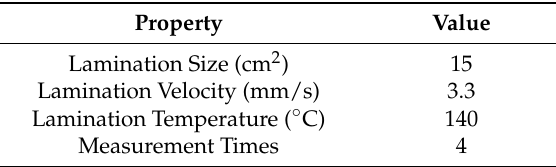
Table 2. Experimental conditions to produce PAN nanofiber air filter by the heat roller of SKY 325R6 model.